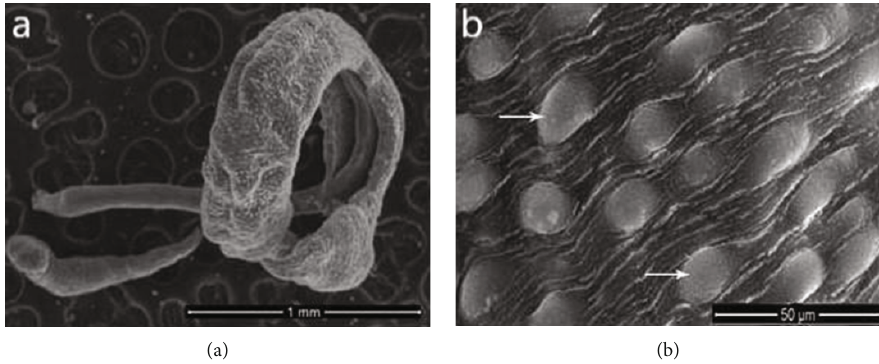
Figure 7: Normal tegument of S. mansoni from the rat tissue.